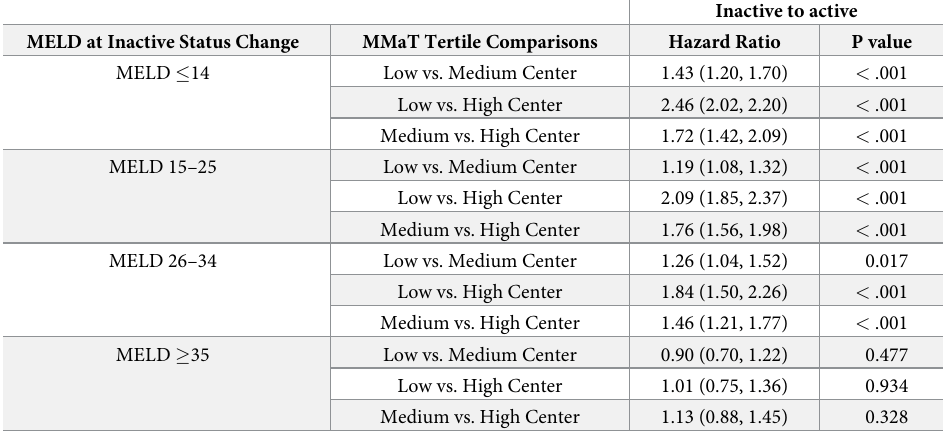
Table 4. Hazard ratios of transition from inactive to active status stratified by transplant center MMaT tertile.